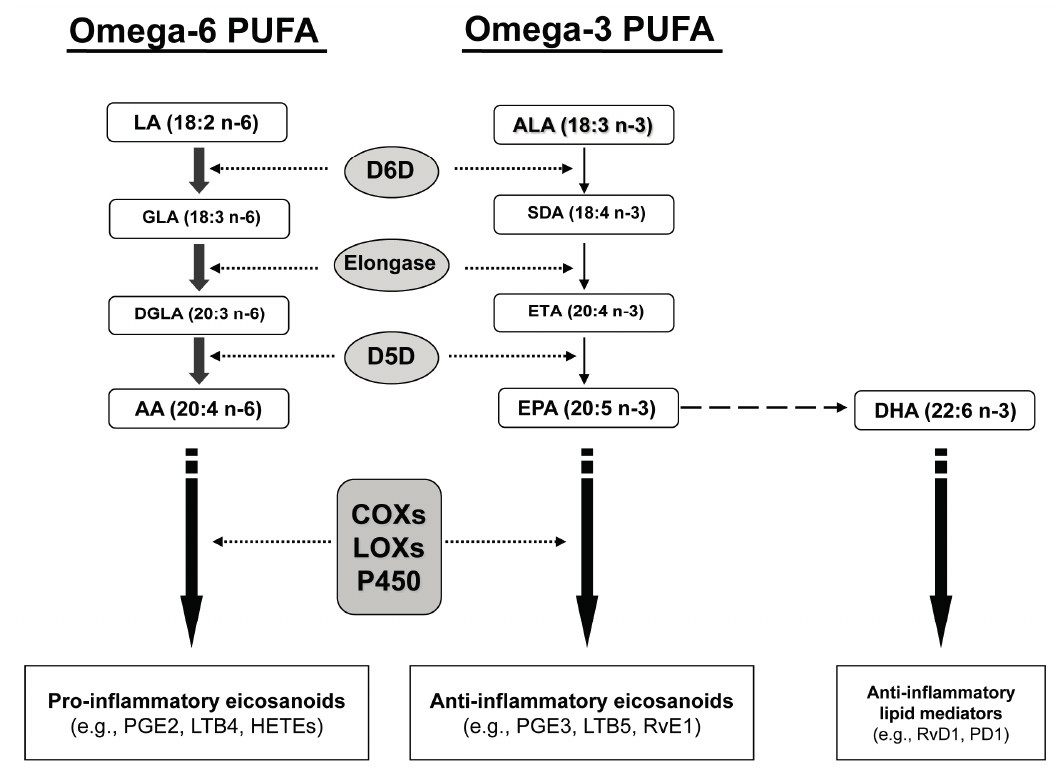
Figure 1. Diagram of the metabolic pathways for n-6 and n-3 polyunsaturated fatty acids (PUFA). Omega-6 linoleic acid (LA) and n-3 α -linolenic acid (ALA) cannot be synthesized by mammalian cells and must be obtained through the diet. They can be further elongated and desaturated by δ -6-desaturase (D6D), elongase, and D5D to form n-6 arachidonic acid (AA) and n-3 eicosapentaenoic acid (EPA), respectively. AA and EPA can then be converted by cyclooxygenases (COX), lipooxygenases (LOX), and cytochrome P450 (CYP 450) into pro- and anti-inflammatory eicosanoids, including prostaglandins (PG), leukotrienes (LT), thromboxanes (TX), hydroxyeicosatraenoic acids (HETE), and resolvins (Rv). The n-3 docosahexaenoic acid (DHA) can be converted into Rvs and protectins